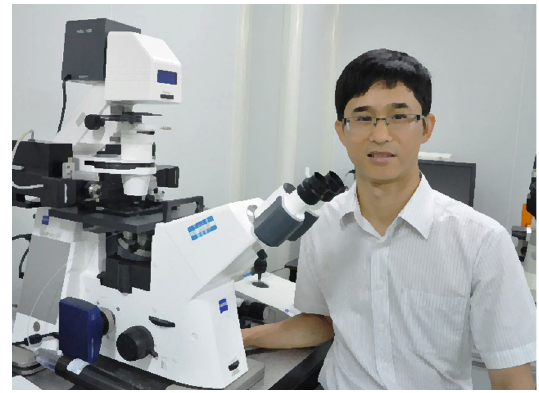
Figure 1. Dr. Junjiu Huang.